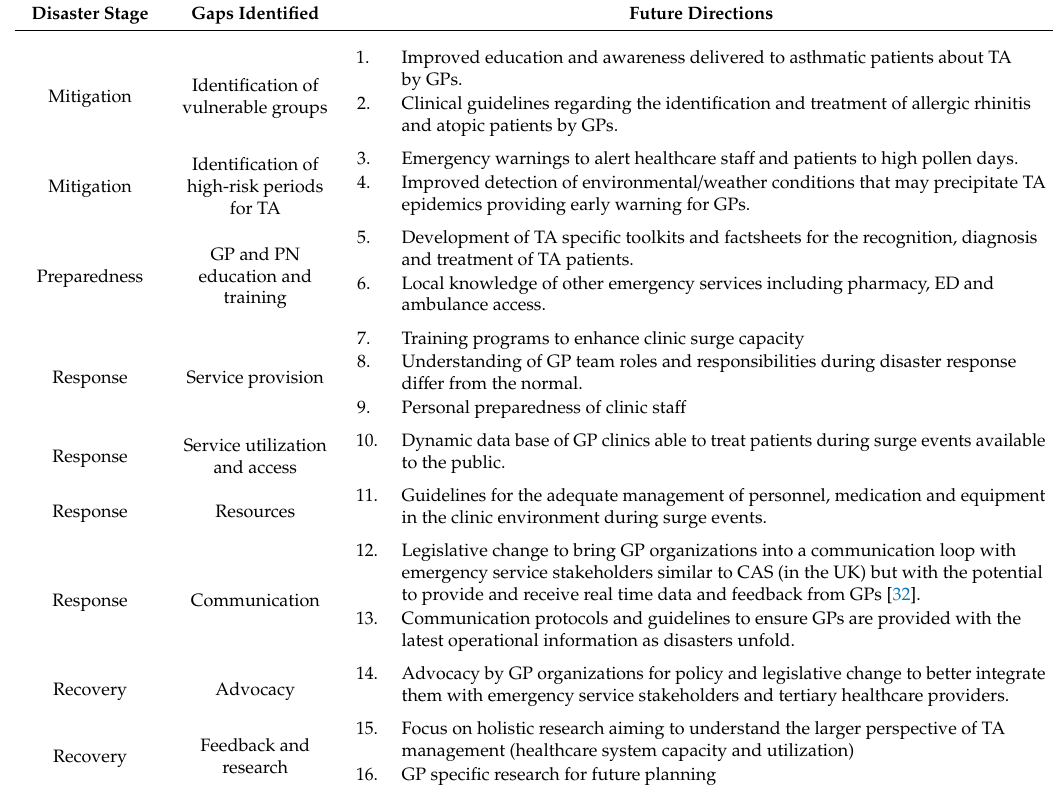
Table 2. Gaps identified and future